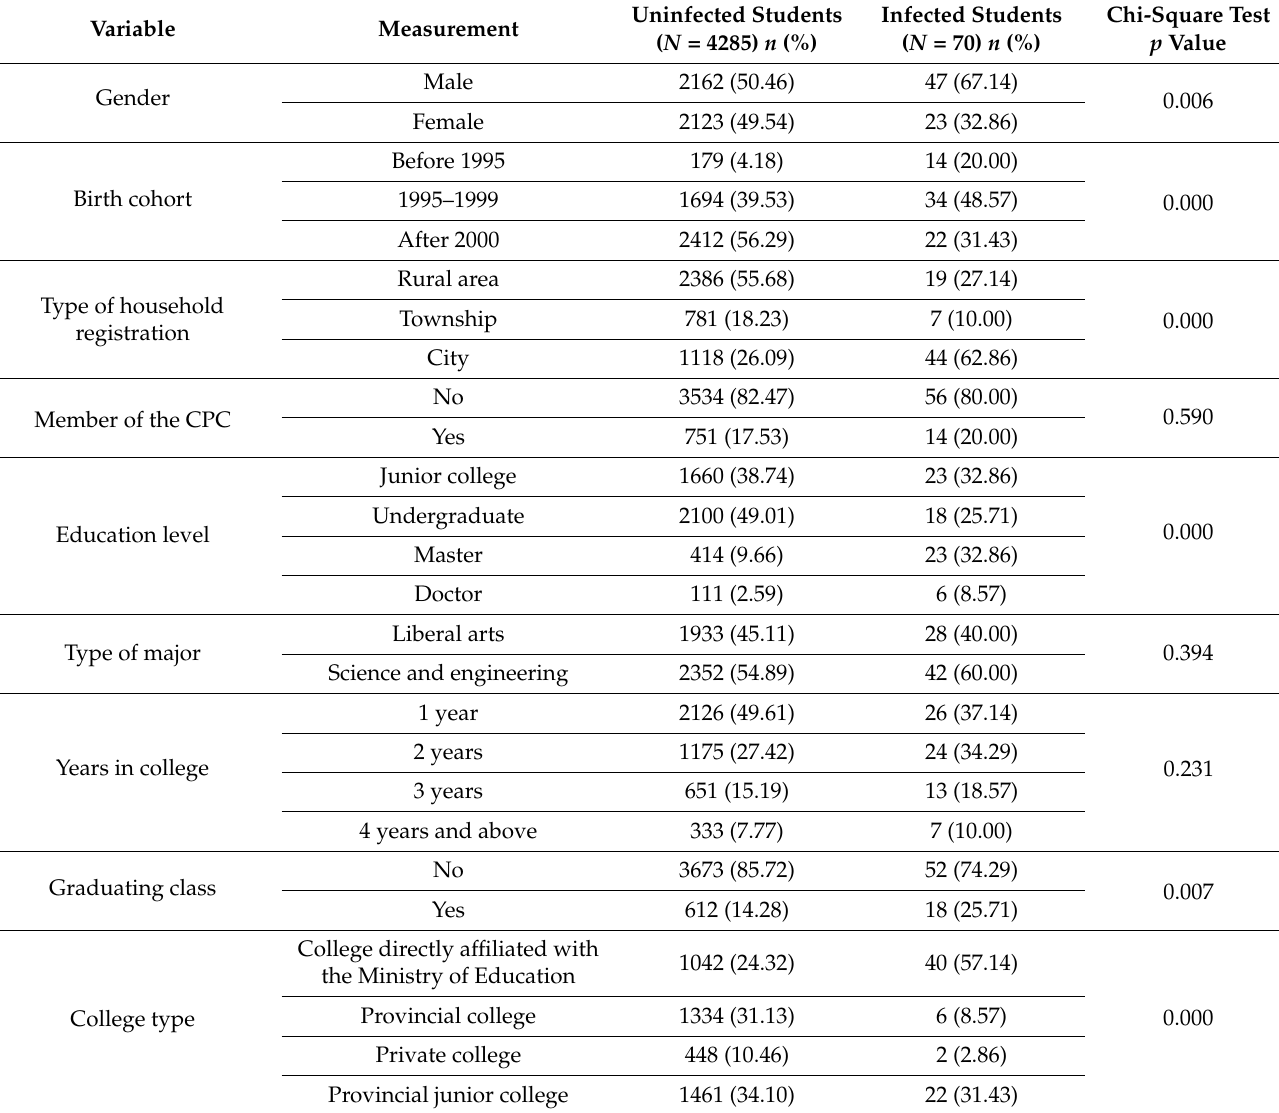
Table 5. Characteristics of infected and uninfected students in